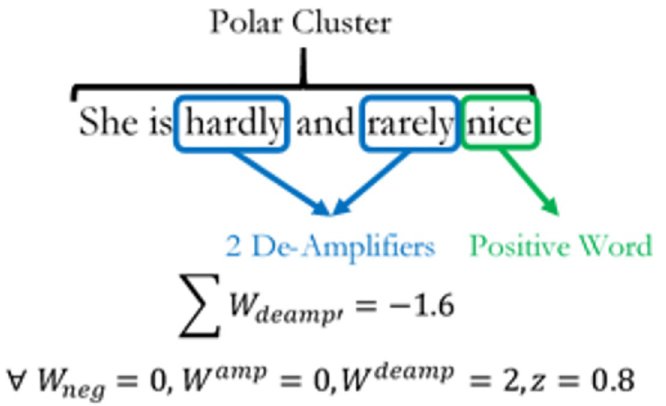
Fig 4. Positive de-amplification. The diagram shows the positive de-amplification of words in a sentence.